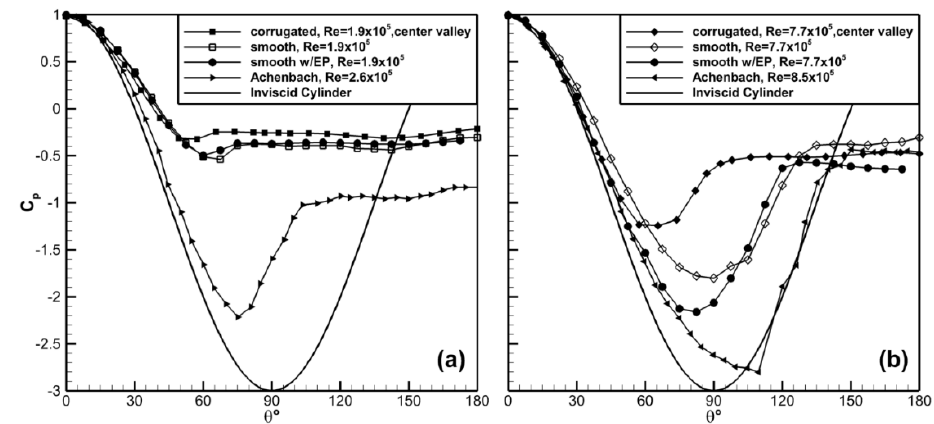
Figure 9. Comparison of the surface pressure distribution around the corrugated and smooth cylinders. ( a ) Re = 1.9 × 10 5 , ( b ) Re = 7.7 × 10 5